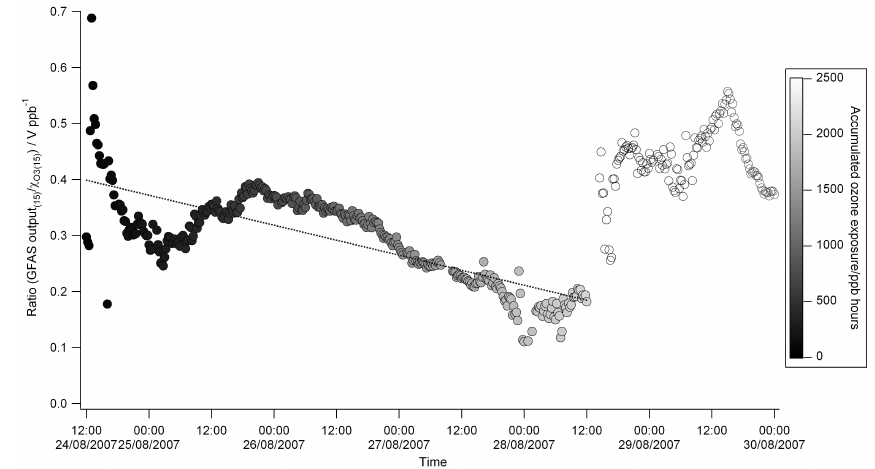
Fig. 1. Ratio of 15min relative ozone concentration (GFAS mean output) and absolute ozone concentration for Disc Period 6 (closed symbols) and Disc Period 7 (open symbols). Fitted slope, i.e. trend in ratio is − 6 . 21 × 10 − 7 Vppb − 1